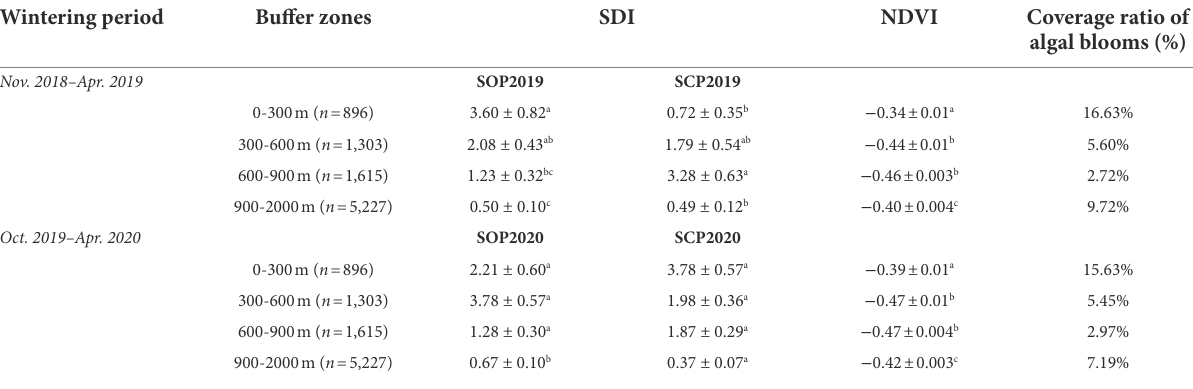
TABLE 1 SDI, NDVI, and coverage ratio of algal blooms in different buffer zones at Dianchi Lake, Kunming City, Yunnan Province, southwestern China.